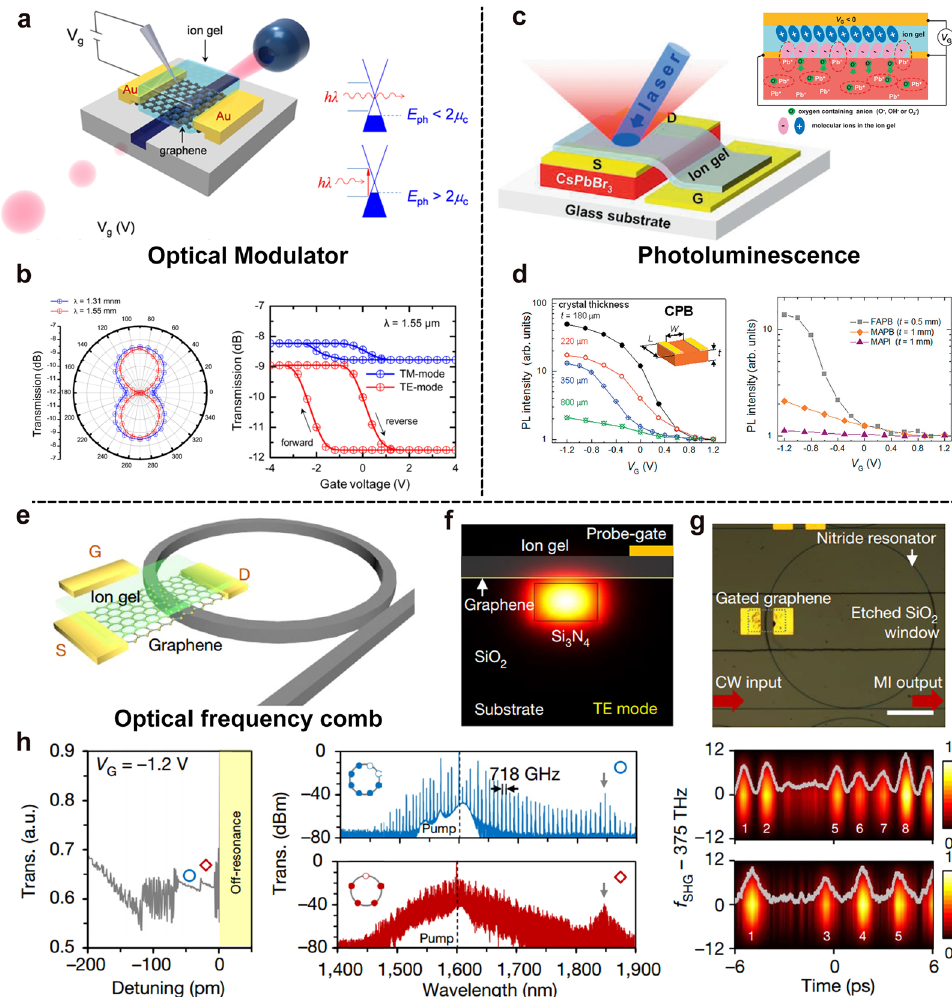
Fig. 4 Applications of phototransistor formed by ionic-gel. a Schematics of ionic-gel-integrated optical-transistor modulator. Reproduced with permission 74 . Copyright 2017, American Chemical Society. b The polar image measured under the presence of the ionic-gel and the optical transmission of phototransistor according to the top gate voltage at a wavelength of 1.55 μ m. c Scheme of the IGT photoluminescence devices with a lead-halide perovskite single-crystal integrated with an ionic gel. Reproduced with permission 75 . Copyright 2019, Elsevier. d The relationship between V G -induced modulation of PL intensity and the device geometry (the crystal thickness and photoexcitation area) of perovskite EDLTs. e Schematic architecture of the graphene-based microresonator. The gray object showed is the silicon nitride. Reproduced with permission 78 . Copyright 2018, Springer Nature. f Electric fi eld distribution of the graphene – nitride heterogeneous waveguide, with a Si 3 N 4 cross-section of 1.2×0.8 μ m 2 . The distance between the Si 3 N 4 waveguide and the graphene layer is 100nm. The graphene and the top-gate probe are separated by 1 μ m with the interlayer ionic-gel capacitor. In this structure, transverse electric (TE) mode is applied. g Optical micrographs show the bus waveguide (red arrows), ring resonator, and Au/Ti metallized patterns. An etched window is designed to ensure both graphene – light interaction and reduced propagation loss. Here the graphene-covered area is marked by the gray dashed box; the etched window label refers to the whole horizontal area between the two central lines. CW continuous wave, MI modulated intensity. Scale bar, 100 μ m. h Soliton state with crystal-like defects modulated by heterostructure transistor. The middle and right graphs are the corresponding spectral measurements and the frequency-resolved second harmonic autocorrelation graphs of soliton pulses. The gray curve here shows the real-time autocorrelation intensity